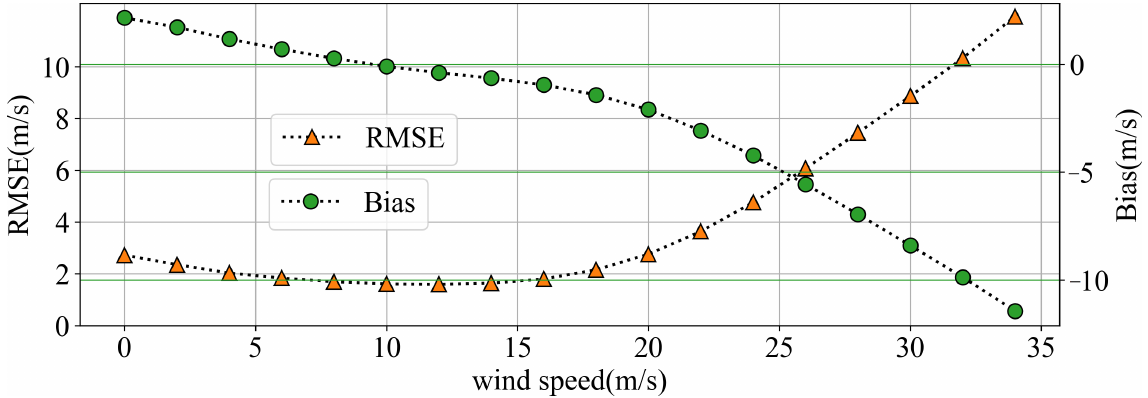
Figure 5. RMSE and bias in wind speed from HY-2B/C/D scatterometers compared to SMAP. The dotted line is marked with triangles to represent RMSE, and the dotted line is marked with circles to represent bias